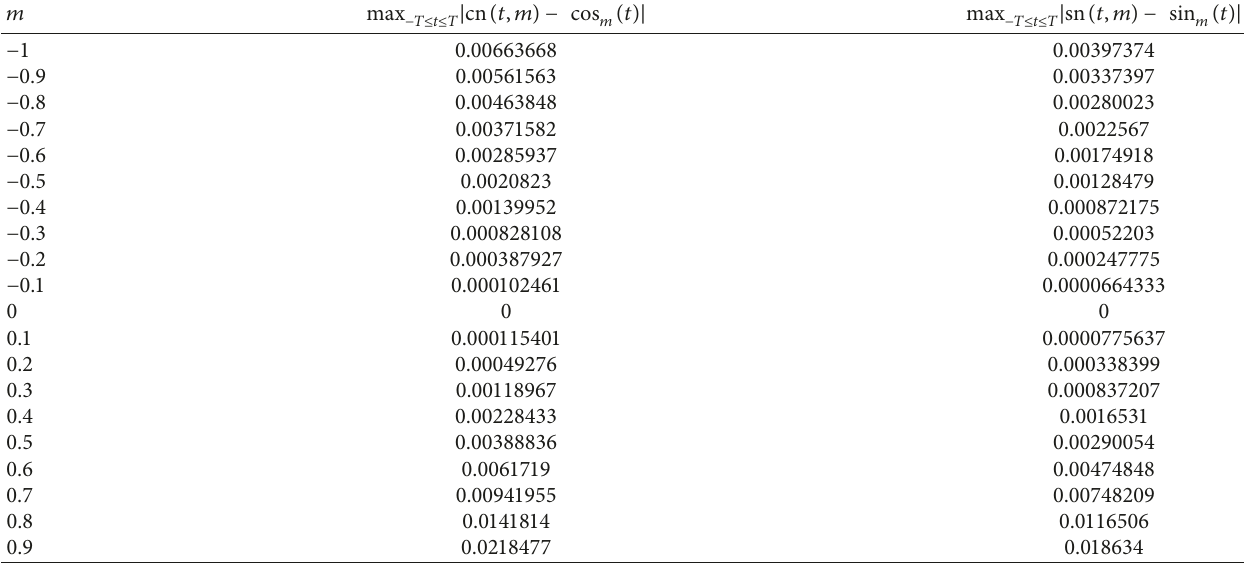
Table 1: Numerical values of approximations (37) and (38).